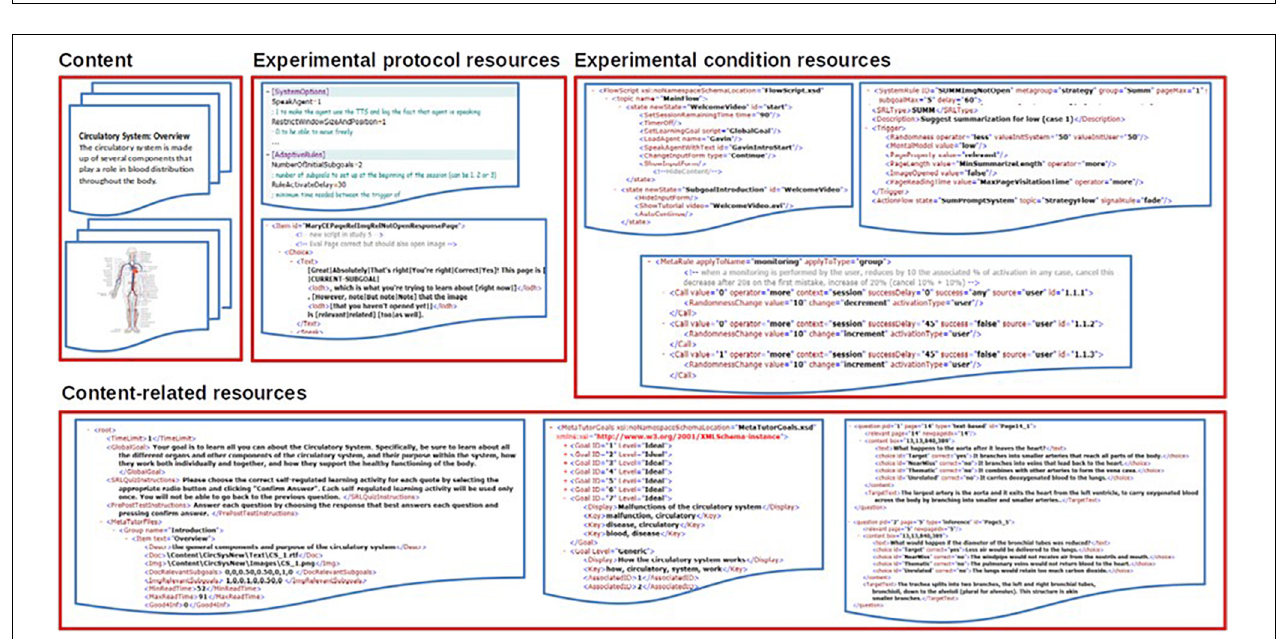
FIGURE 3 | Experimental procedure used for all MetaTutor studies.